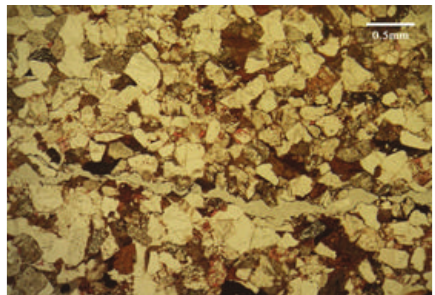
Figure 3: Cast thin section image of this